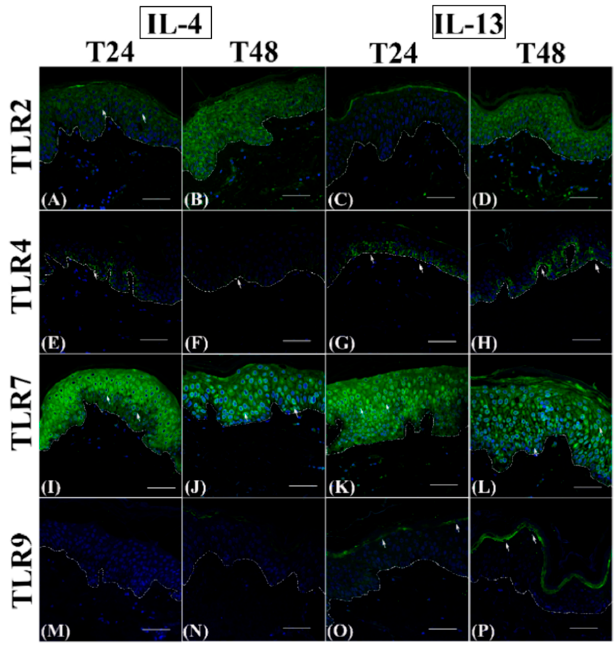
Figure 4. TLR2, TLR4, TLR7, and TLR9 immunofluorescence analysis on IL-4 and IL-13 incubated paraffin human skin sections. Representative TLR2 ( A – D ), TLR4 ( E – H ), TLR7 ( I – L ), and TLR9 ( M – P ) immunostainings in normal human skin paraffin sections. ( A , E , I , M , C , G , K , O ): samples harvested at 24 h; ( B , F , J , N , D , H , L , P ): samples harvested at 48 h. Nuclei are counterstained with DAPI. TLR2: Toll-like receptor 2; TLR4: Toll-like receptor 4; TLR7: Toll-like receptor 7; TLR9: Toll-like receptor 9; IL-4: interleukin 4; IL-13: interleukin 13; DAPI: 4 ′ , 6-diamidino-2-phenylindoledihydrochloride. White dotted line indicates the basal membrane. White arrows indicate positive immunostaining— scale bars: 50 μ m.